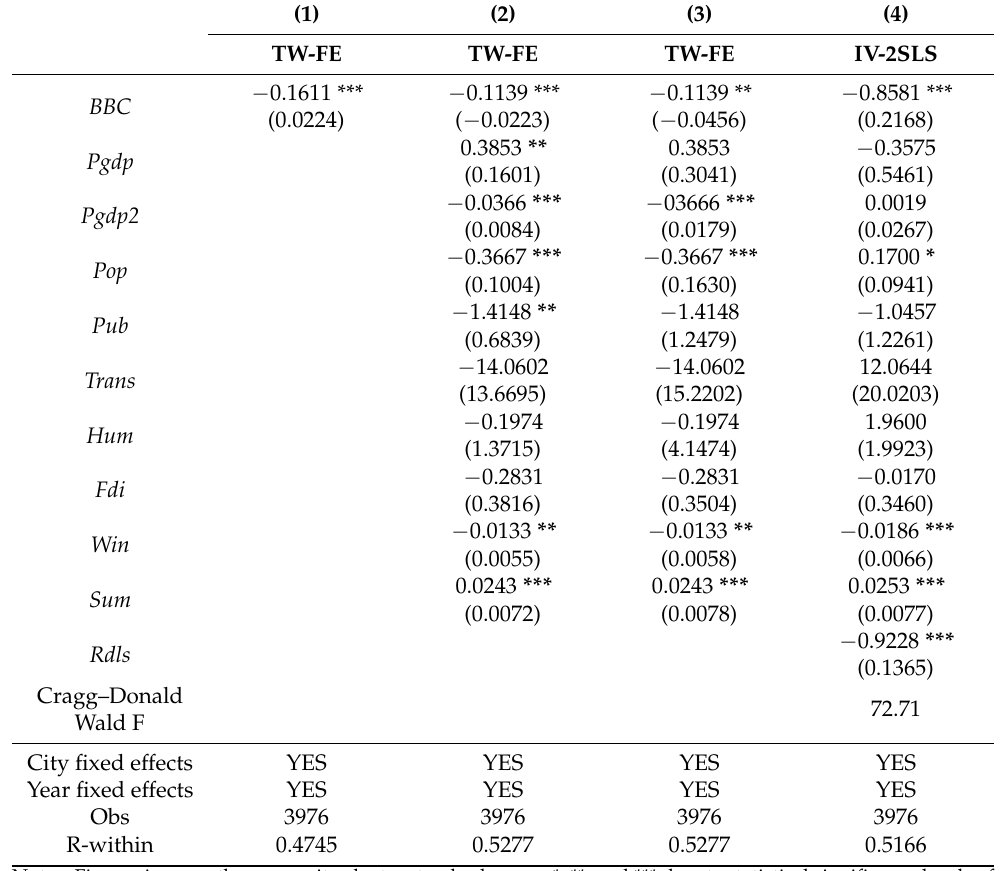
Table 2. The impact of information infrastructure on carbon emission